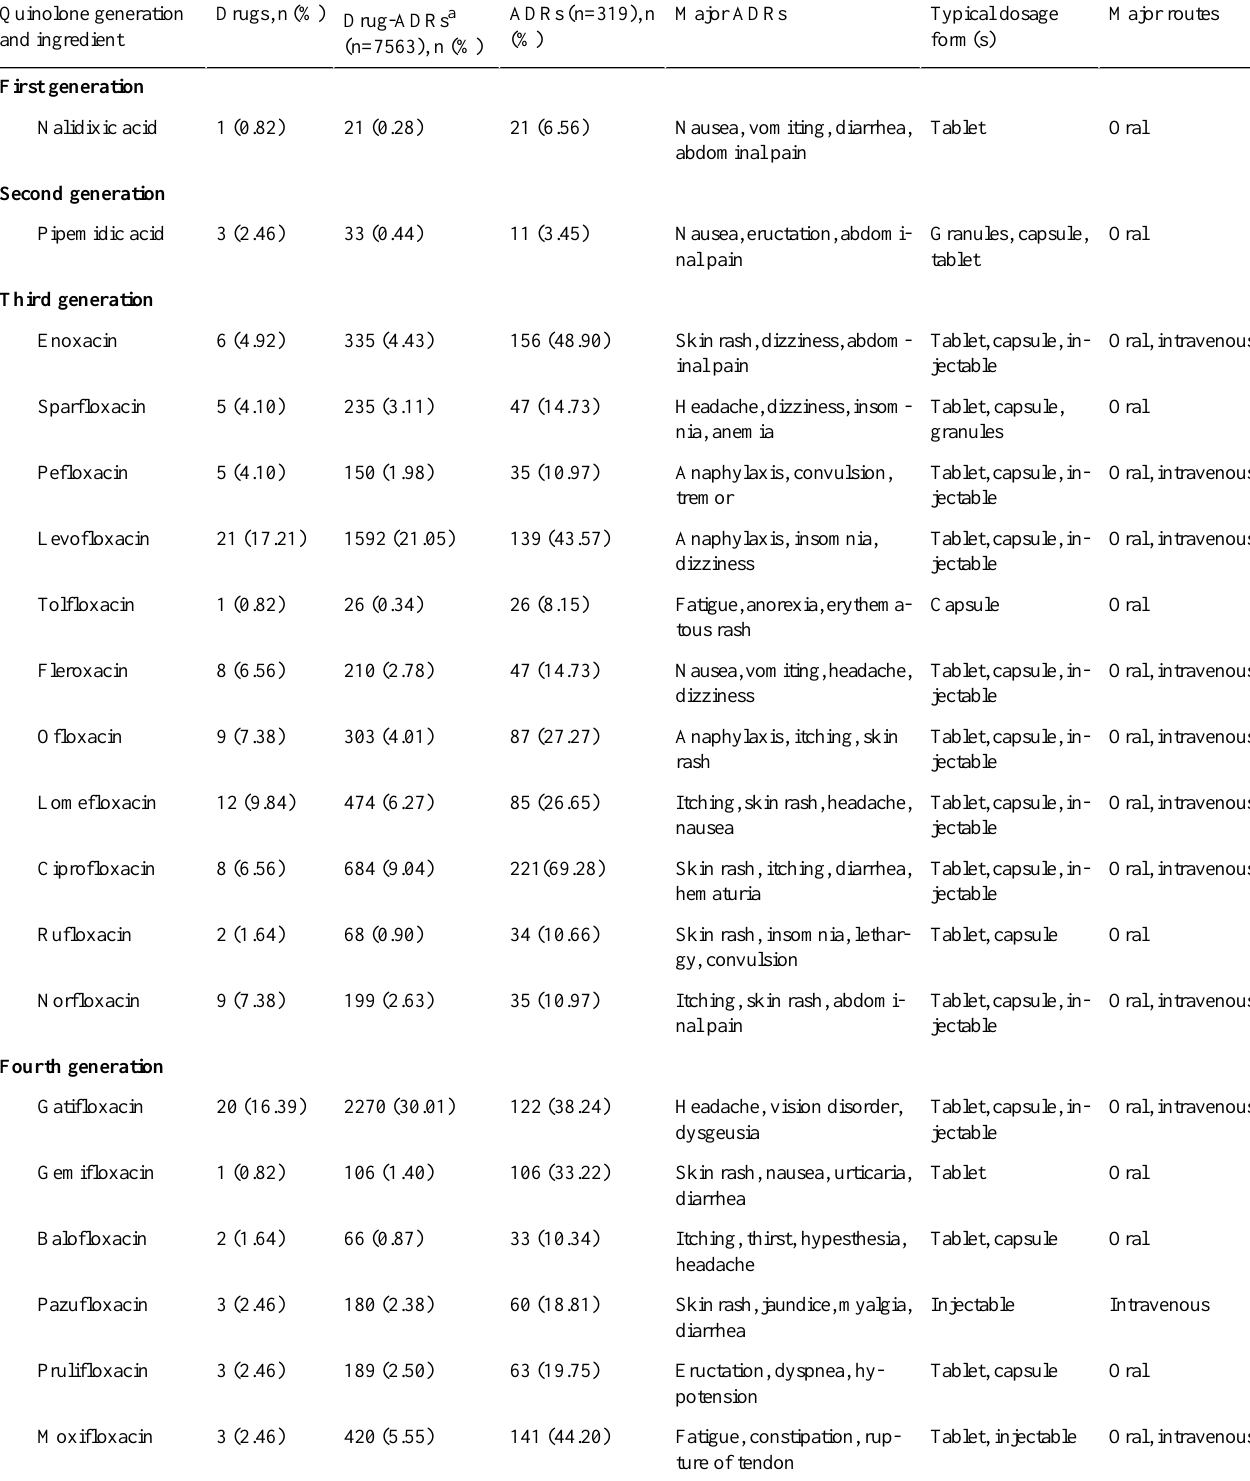
Table 2. Identified adverse drug reactions of quinolones, excluding topical drugs